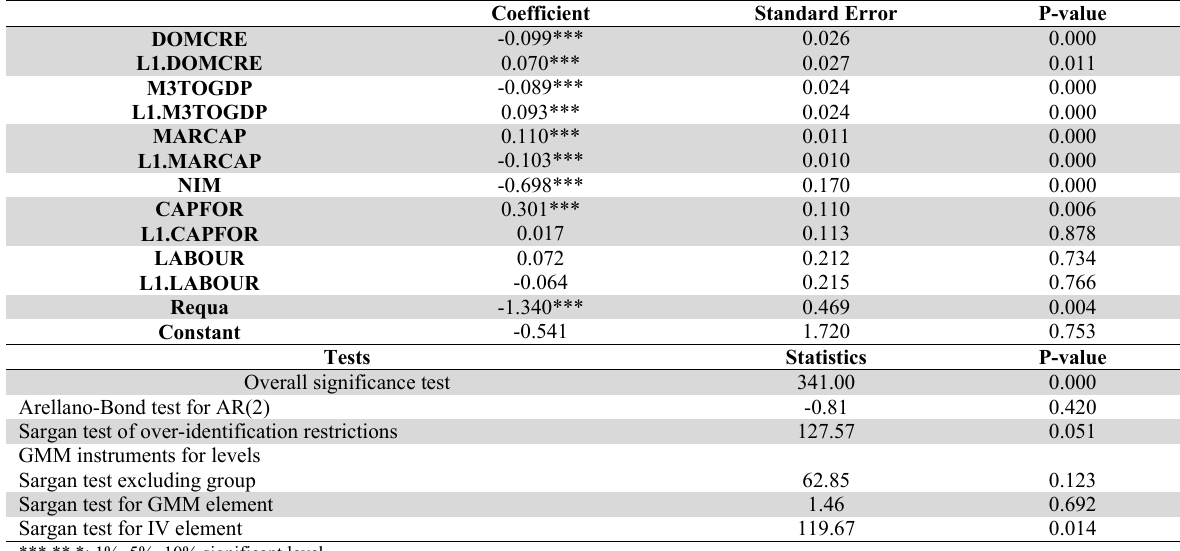
Results of GMM model